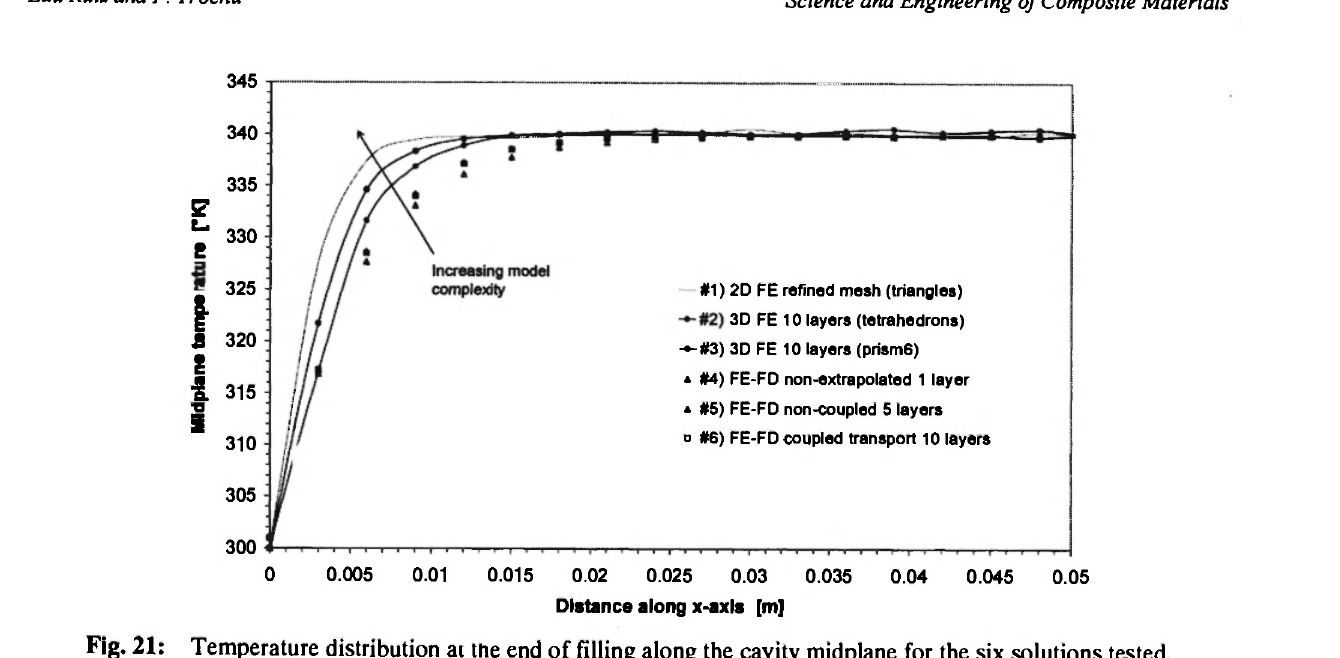
Temperature distribution ai me end of filling along the cavity midplane for the six solutions tested.